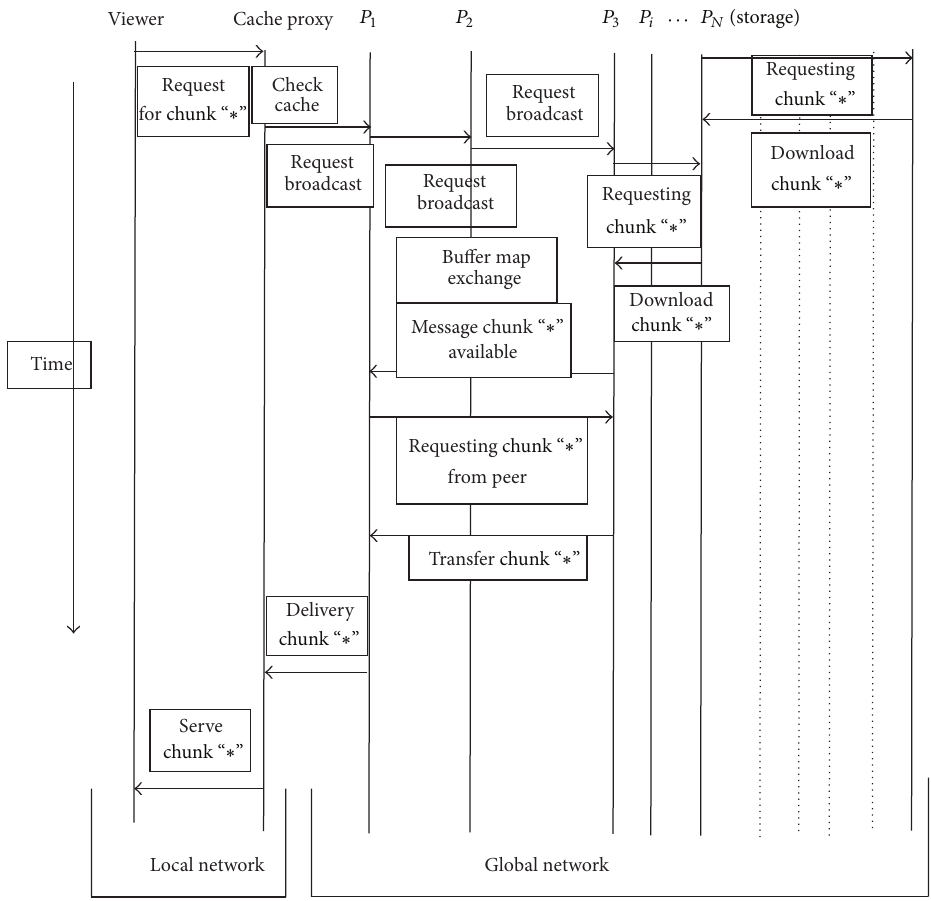
Figure 3: Chunk transfer working